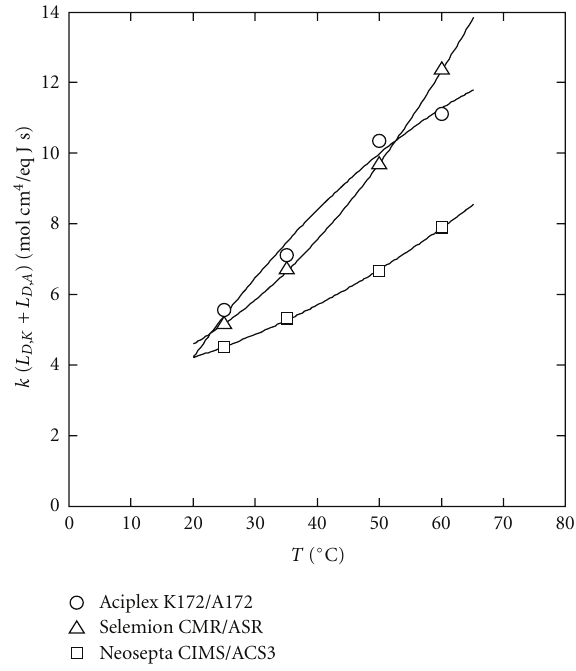
Figure 16: Relationship between temperature and exchange flow parameter.